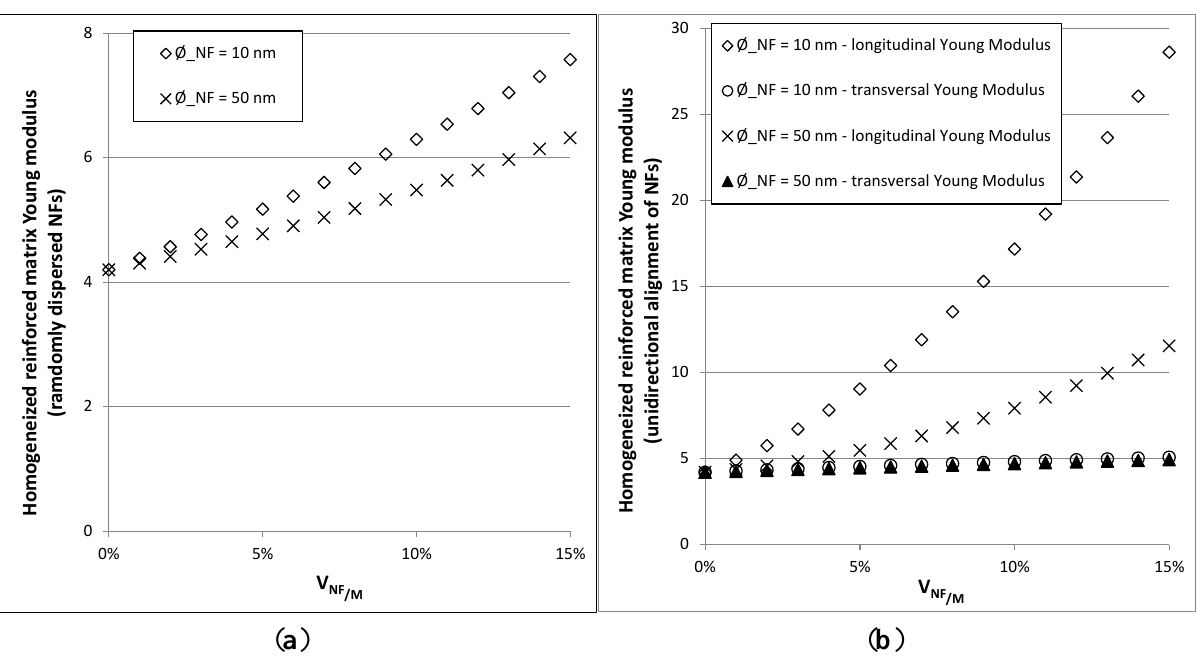
Figure 2. Evolution of the Young modulus of a matrix reinforced by nanofibers in the case of ( a ) isotropic distribution of nanofibers (NFs) into the matrix; and ( b ) unidirectional alignment of